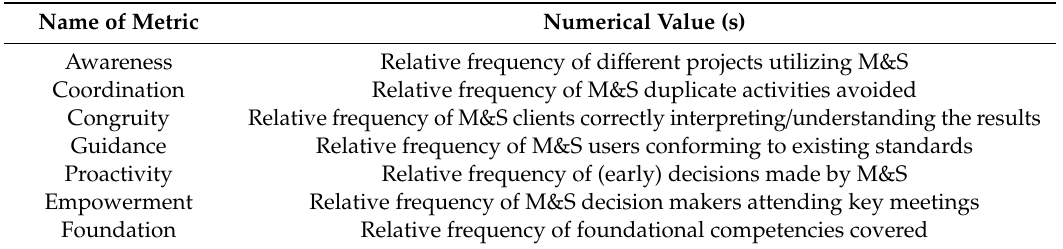
Table 3. Di ff usion metrics and their numerical